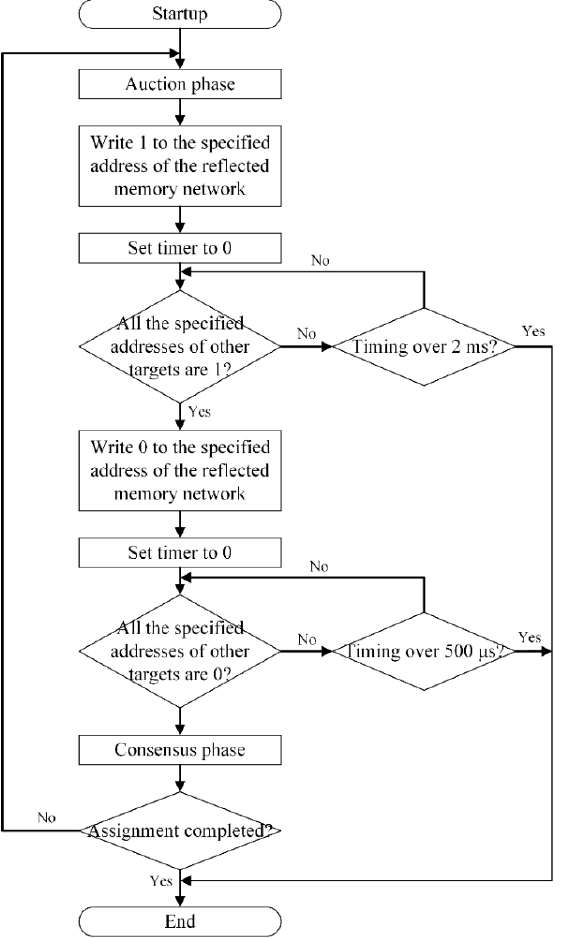
Figure 5. Flowchart of the double handshake mechanism for data communication.